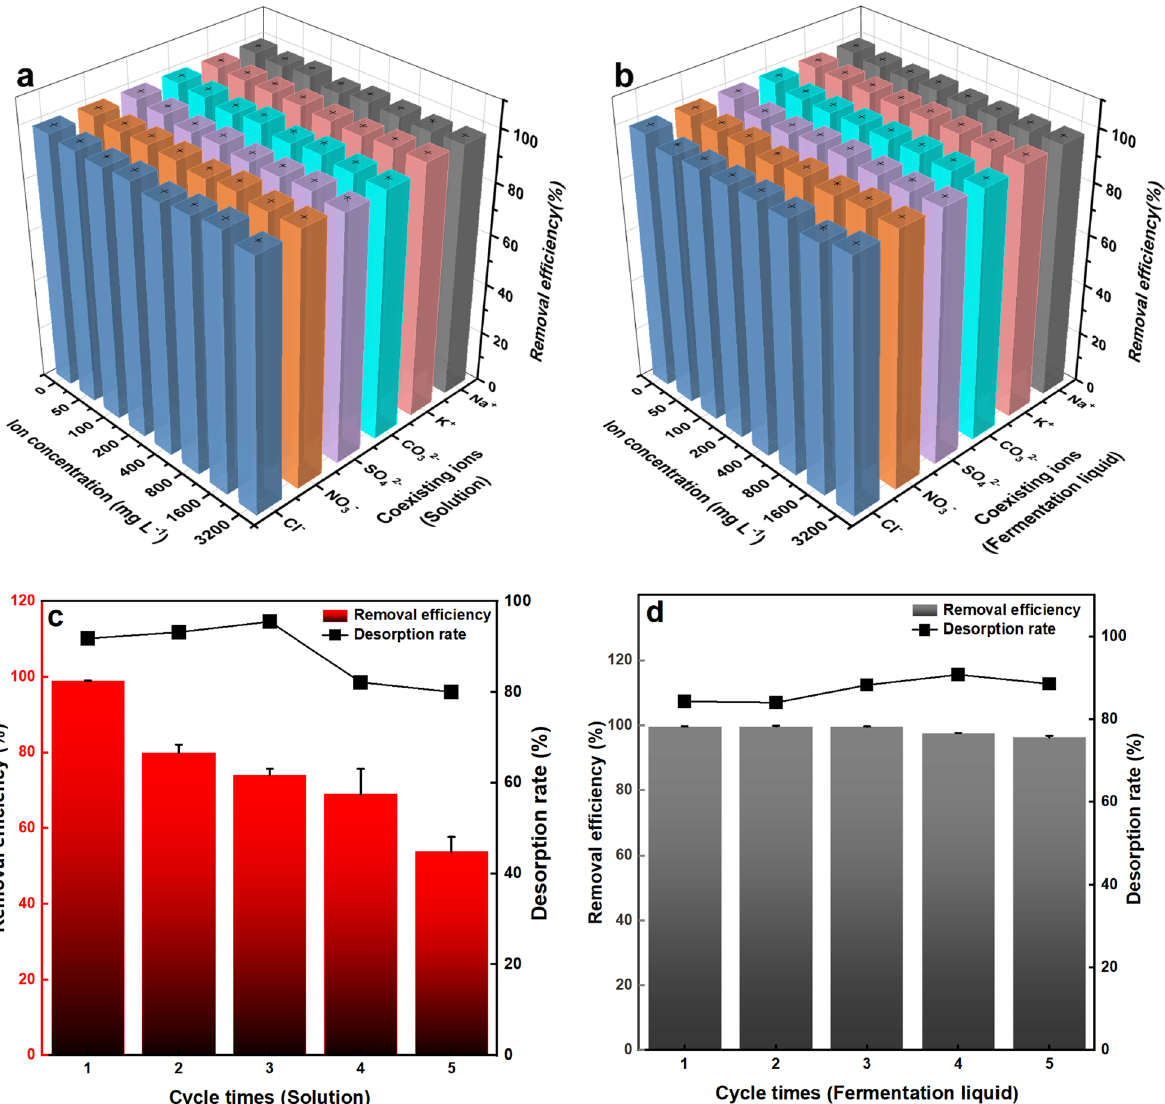
Fig. 6 Impacts of coexisting substances on P adsorption in the synthetic solution ( a ) and the kitchen waste fermentation liquid ( b ); results of the removal efficacy of P by MTC and desorption rate of sorbed P over five sorption-desorption cycles in the synthetic P solution ( c ) and the